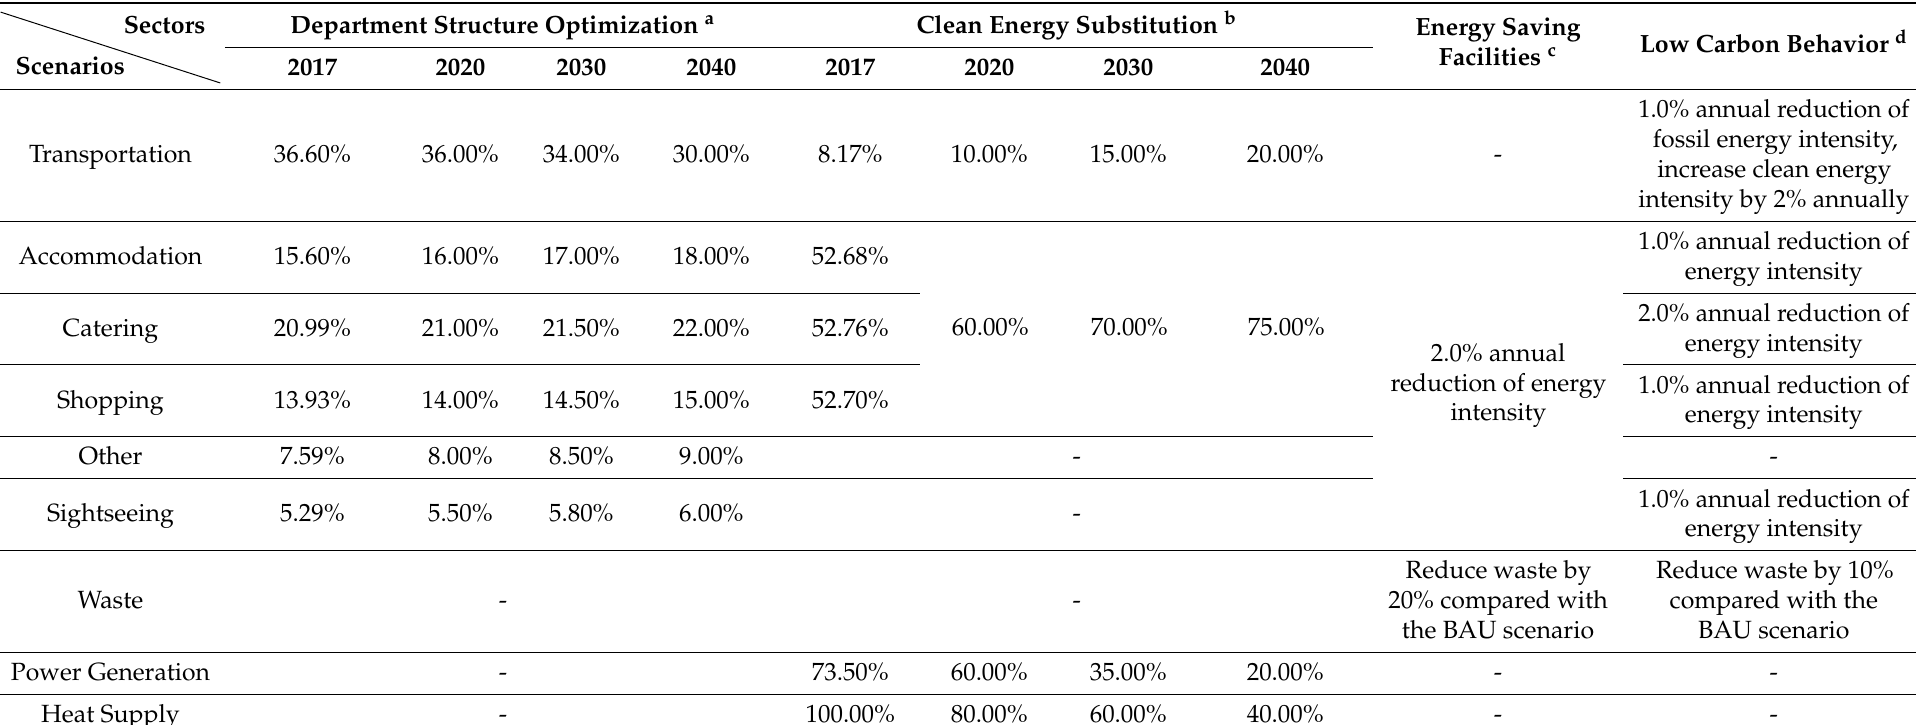
Table 1. Policy options and assumptions for four